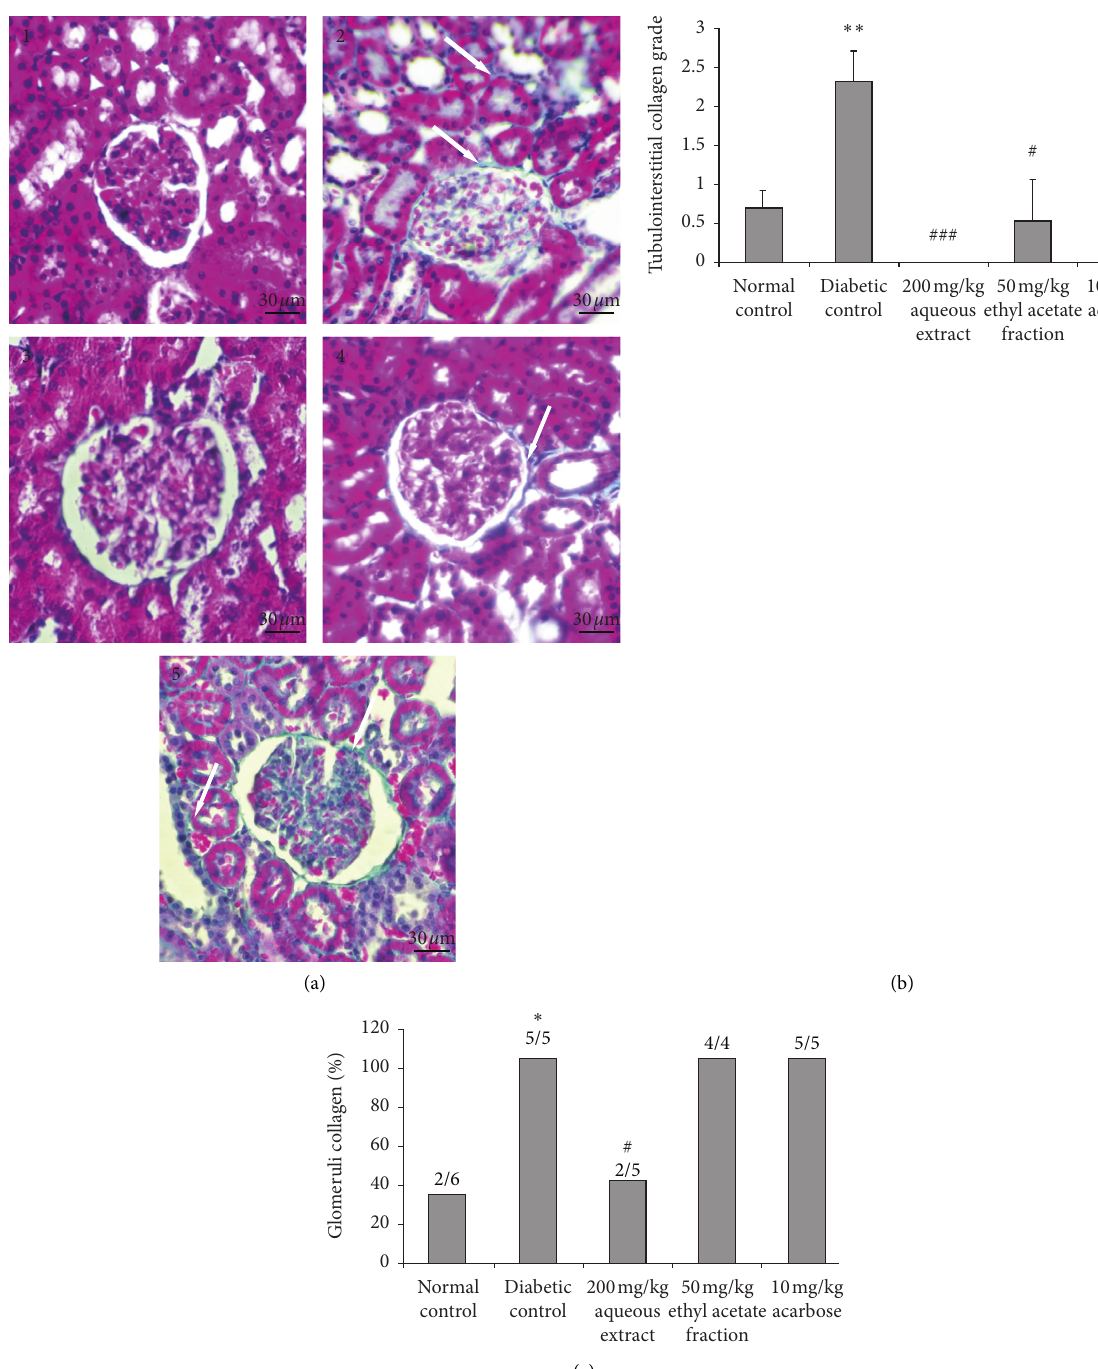
Figure 4: Effect of 200mg/kg AqTh, 50mg/kg EaTh, and 10mg/kg acarbose treatment on glomeruli and tubulointerstilial collagen in the kidneys of STZ-induced diabetic rats after 4-week treatment. (a) Histological appearance of renal tubules and glomerules in normal (1), diabetic (2), AqTh-treated (3), EaTh-treated (4), and acarbose-treated rats (5). (b) Tubulointerstitial collagen grade for all groups. (c) Glomeruli collagen for all groups. Sections were stained in Masson’s trichrome and observed in light microscope (original magnification × 400). White arrow: collagen. Each value represents the means ± SEM. n � 5-6. x/x: number of rats with glomeruli collagen in the group. ∗ p < 0 . 05 and ∗∗ p < 0 . 01 compared to normal rats. ns p > 0 . 05 compared to diabetic rats; # p < 0 . 05 and ### p < 0 . 001 compared to diabetic rats. All statistical tests were used with one-tail p